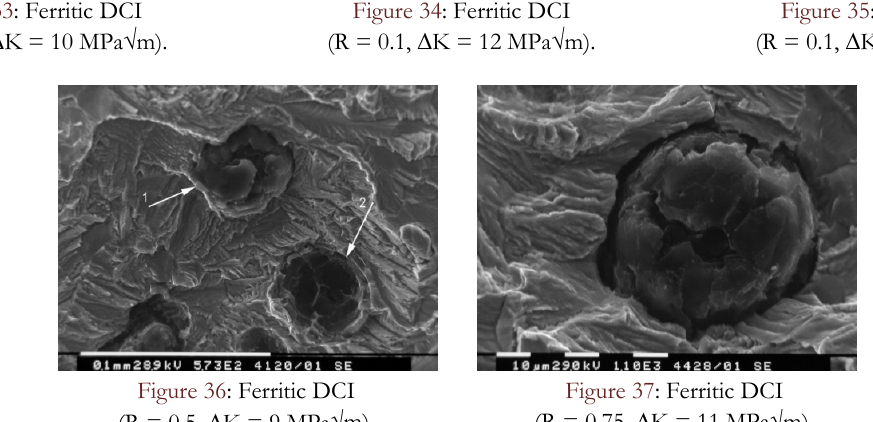
Figure 35: Ferritic DCI (R = 0.1,  K = 19 MPa √ m).